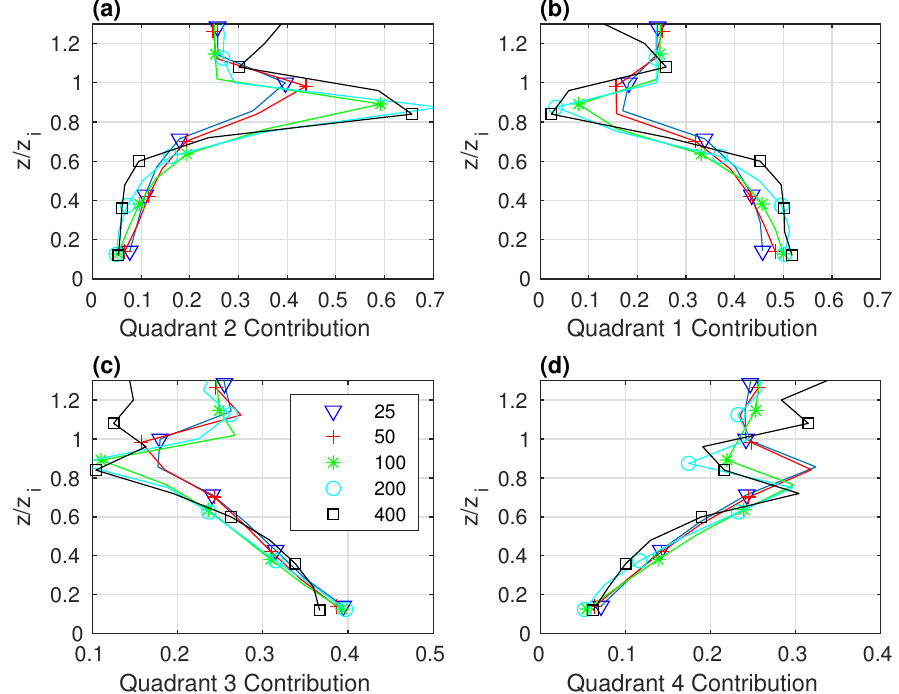
Figure 12. Effect of coarse graining data from the CBL2 simulations to the 400 m grid on the partitioning of the resolved potential temperature flux into different quadrants. Relative contributions of the flux in each quadrant, computed as |(cid:104) w (cid:48) θ (cid:48) (cid:105) i | / ∑ i |(cid:104) w (cid:48) θ (cid:48) (cid:105) i | , are shown for ( a ) Quadrant 2, ( b ) Quadrant 1, ( c ) Quadrant 3 and ( d ) Quadrant 4. Each line is for a simulation with a different grid length, the values in m being indicated in the